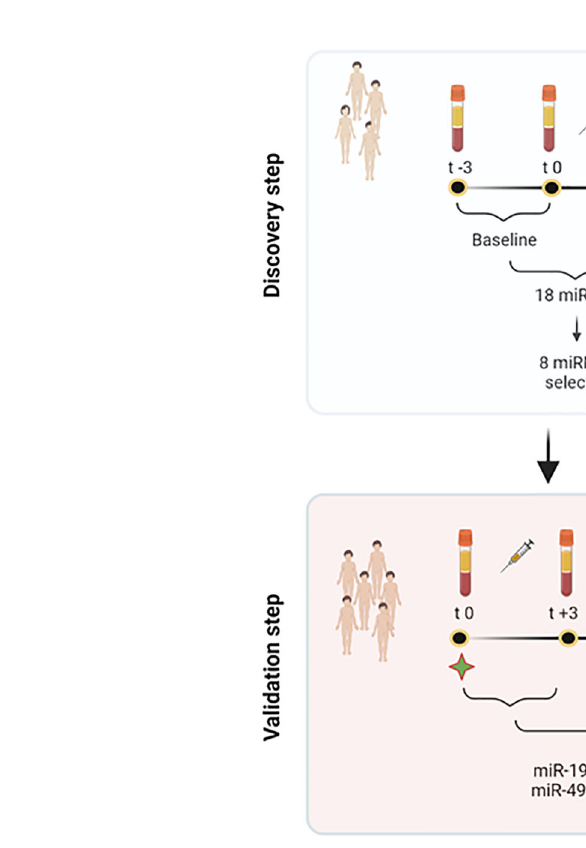
FIGURE 1 | Study work fl ow. In the discovery step, a pro fi ling approach was used, and all those miRNAs showing spontaneous variations independent of treatment ( − 3 and 0 months) were excluded from further analyses. Eighteen miRNAs were found to show changes at +3 months. Based on their function, 8 miRNAs were selected out of this initial pool of 18. The validation phase used TaqMan Real-Time qRT-PCR approach and studied the response of these 8 miRNAs at 3 months on GH treatment in 25 patients. Three speci fi c miRNAs were found to change signi fi cantly on treatment, and were included, together with other clinical and biochemical variables, to contribute to explain growth after 1 year of treatment. To further understand miRNA changes on treatment, these were further measured in serum at 12 months. Green stars in the fi gure represent time points in which clinical and biochemical data have been recorded (t0, t+6, t+12). BA, bone age; CA, chronological age; F, females; GH, growth hormone; M, males; n, number; pts, patients; yr, years. Created with